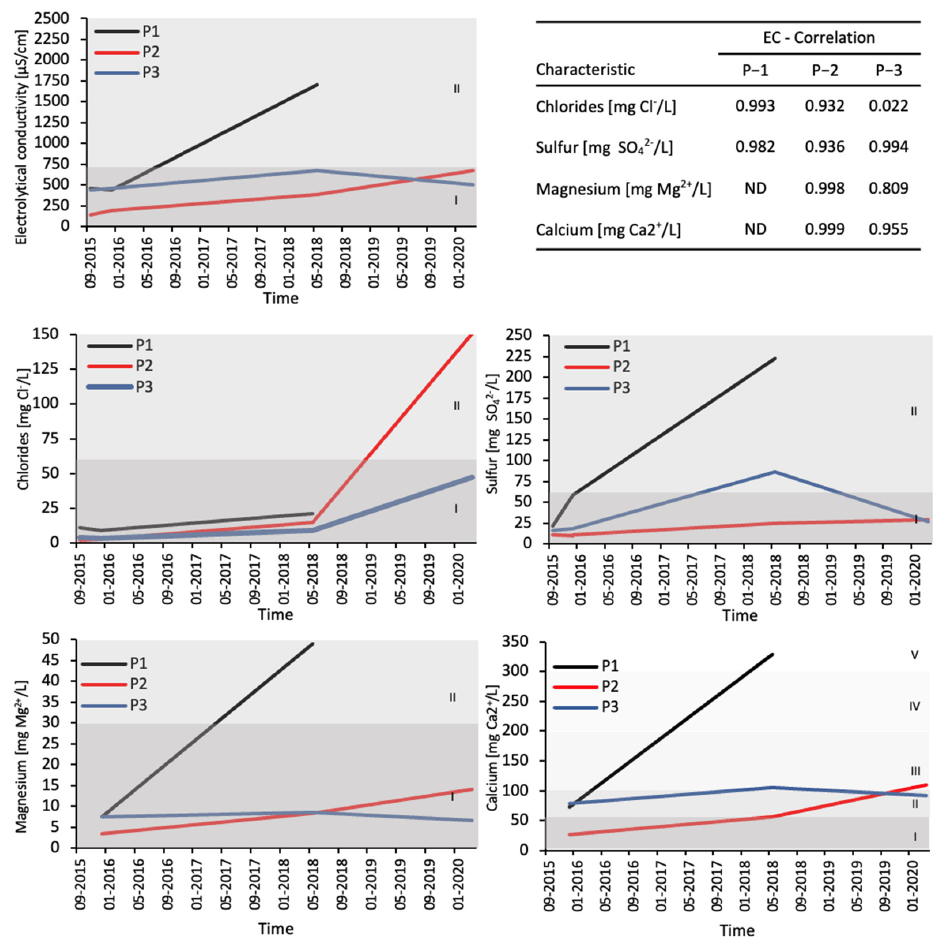
Figure 9. Graphical and tabular representation of the correlation between electrolytic conductance and the groundwater ion concentration at the ZUOK in Olsztyn between September 2015 and March 2020. Roman numerals I-V indicate the quality class levels of the groundwater.